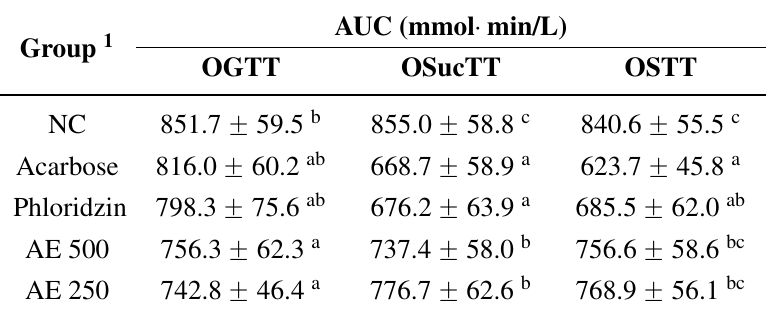
Figure 2. Effect of normal control (NC), acarbose, phloridzin and aqueous extract (AE) of NPV on postprandial blood glucose levels in oral glucose tolerance test. Data is expressed as means ˘ S.E.M. ( n = 6). * p < 0.05, ** p < 0.01 vs. the NC group. Table 1. Area under the curve (AUC) of postprandial glucose responses of normoglycemic rats in oral glucose tolerance test (OGTT), oral sucrose tolerance test (OSucTT) and oral starch tolerance test